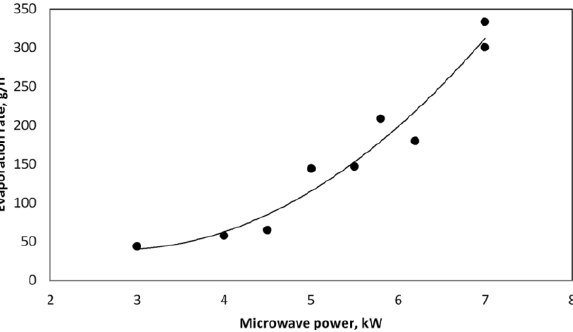
Fig. 3. Evaporation rate of WO 3 versus microwave power This method was upgraded by the use of a subtera- hertz gyrotron setup with output frequency of 263 GHz and a nominal power of 1 kW as a radiation source.